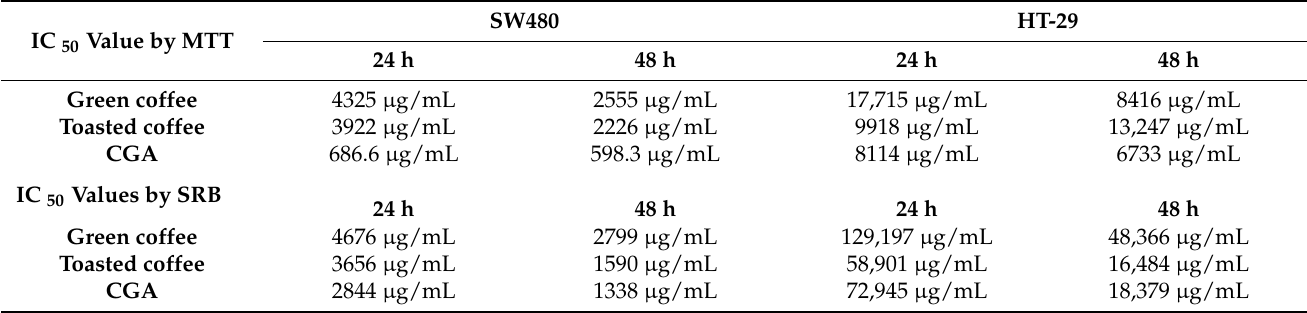
Table 2. Half maximal inhibitory concentration (IC50) values by MTT and SRB methods on SW480 and HT-29 cells treated with green and toasted coffee extracts (GC, TC) and chlorogenic acid (CGA).